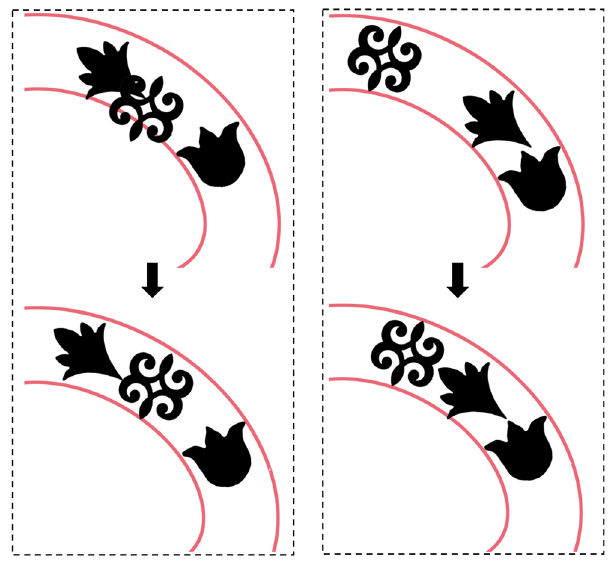
Fig. 5 User edited patterns (top) are afterwards optimized to a force balancing position